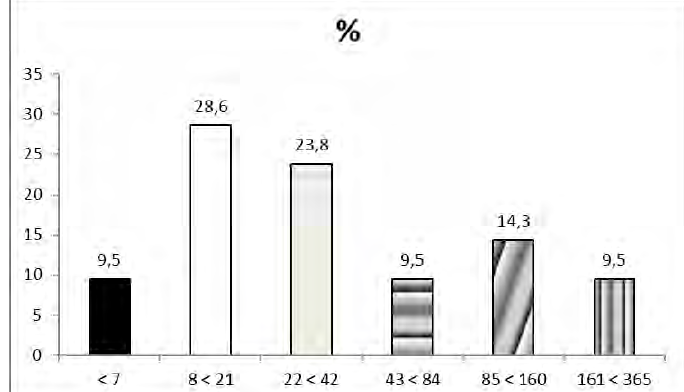
Figure 8. Time (in days) of rehabilitation of